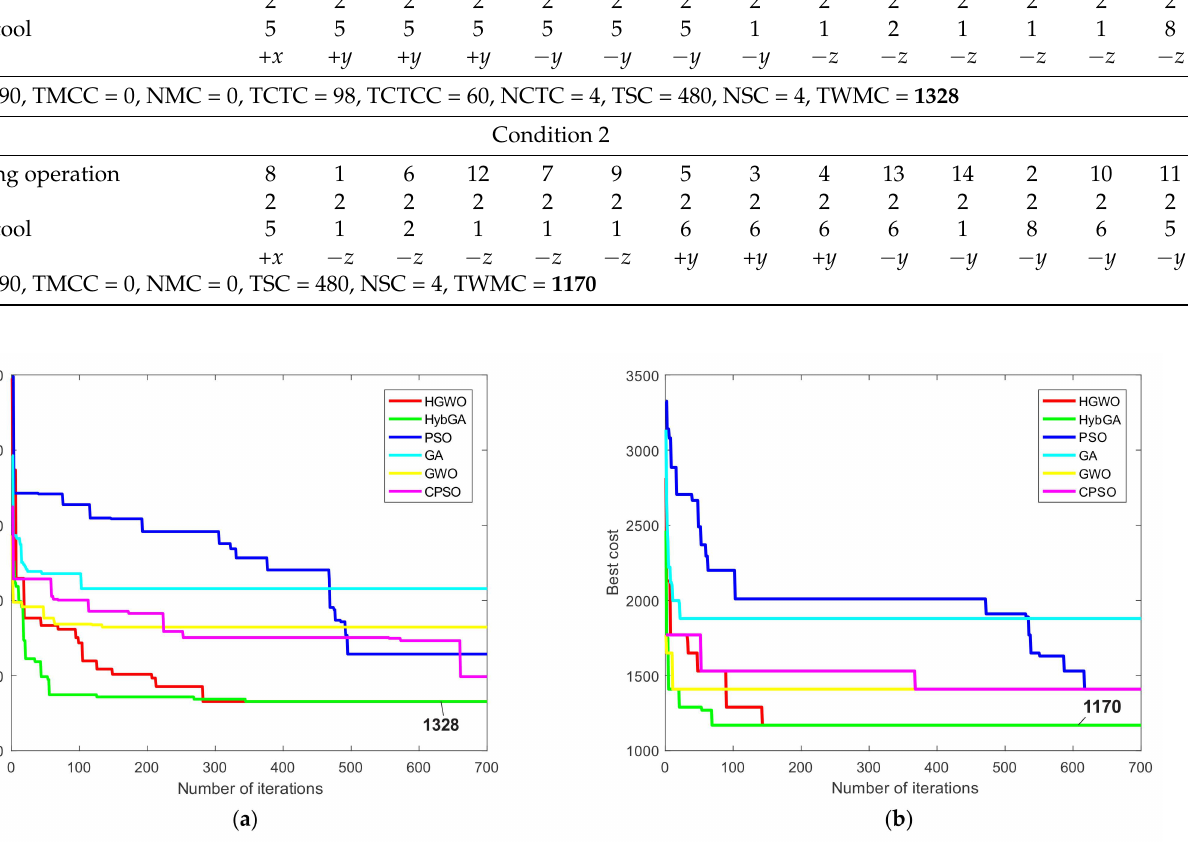
Figure 12. Convergence curves for the prismatic part 2: ( a ) 1st condition; ( b ) 2nd condition. The optimal process plans for prismatic part 3 are obtained and presented in Table